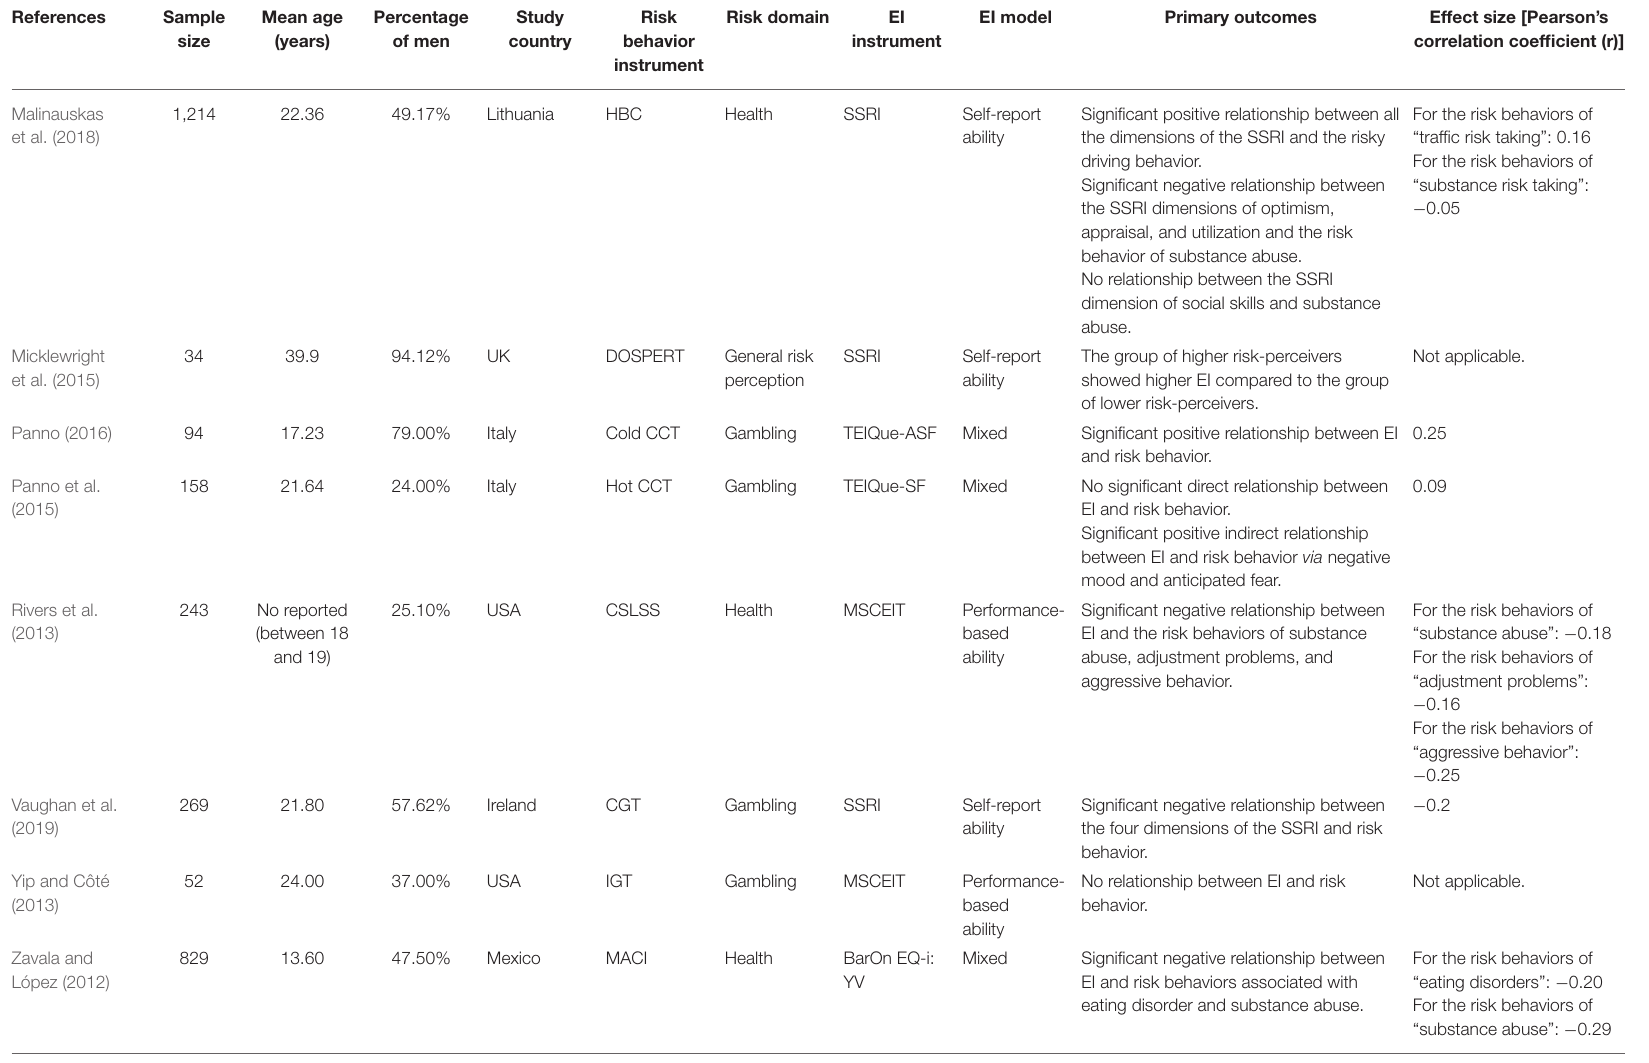
SSRI Self-report Significant negative relationship between ability the four dimensions of the SSRI and risk No relationship between EI and risk Performance- behavior. based ability Mixed Significant negative relationship between EI and risk behaviors associated with eating disorder and substance